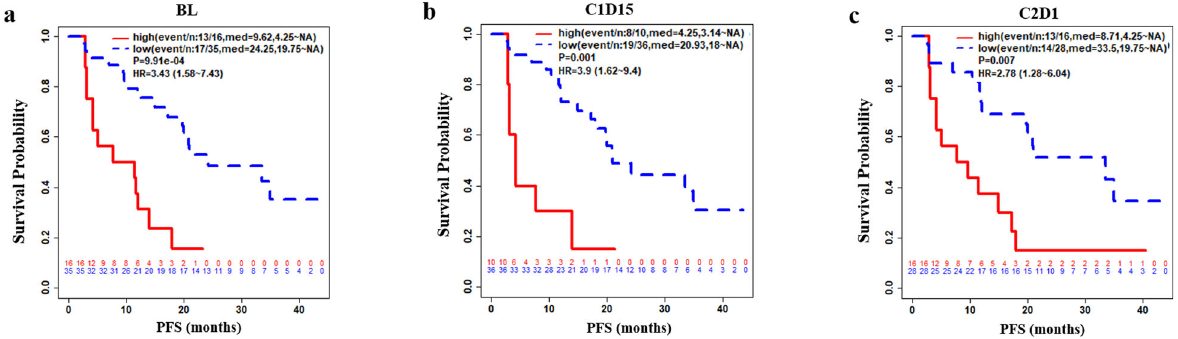
Fig. 3 PFS by sTK1 and time points of baseline (BL), C1D15, C2D1, C4D1. sTK1 cutoff for high versus low is 200 at BL ( a ) and 20 at time points C1D15 ( b ) and C2D1 ( c ). Shown in legends are even/n (number of events/total samples), median PFS, 95% CI by group, log rank test P, and HR (hazard ratio: high sTK1 vs. low sTK1) with 95% CI. The number of patients at risk is indicated at the bottom of each